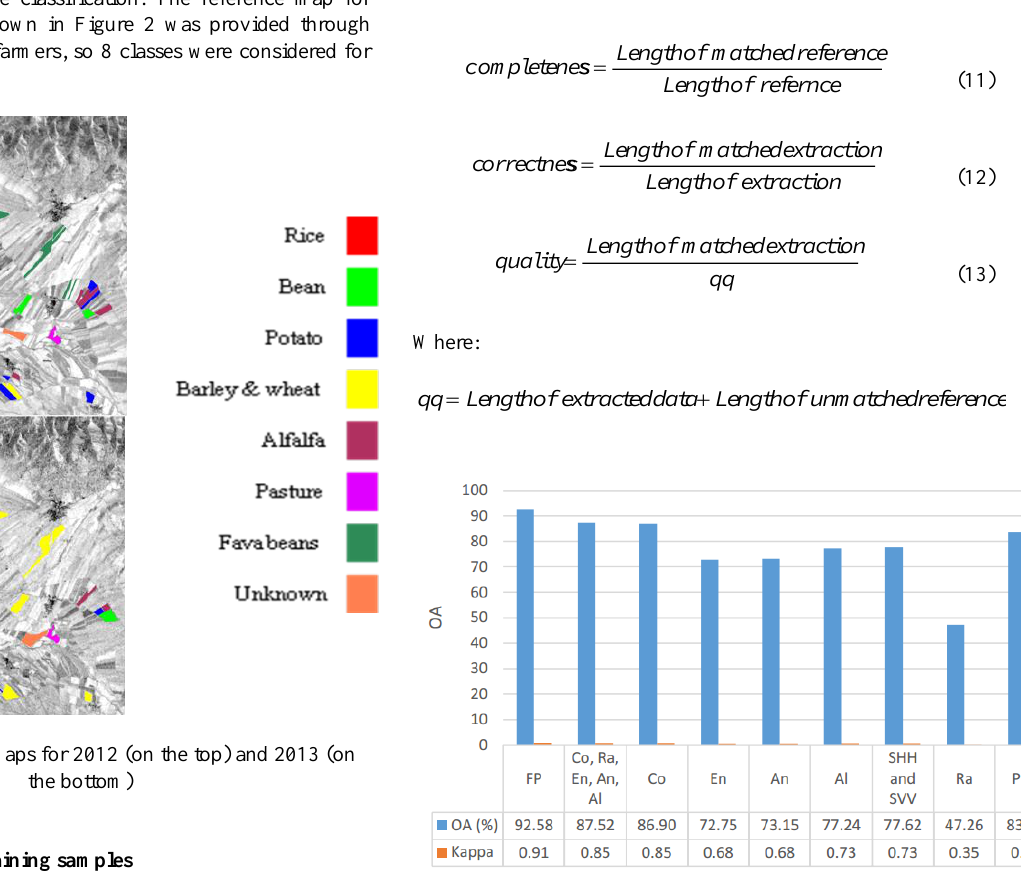
Figure 3: Accuracy assessment of classification results with different parameters combination for the year 2012. FP: Full